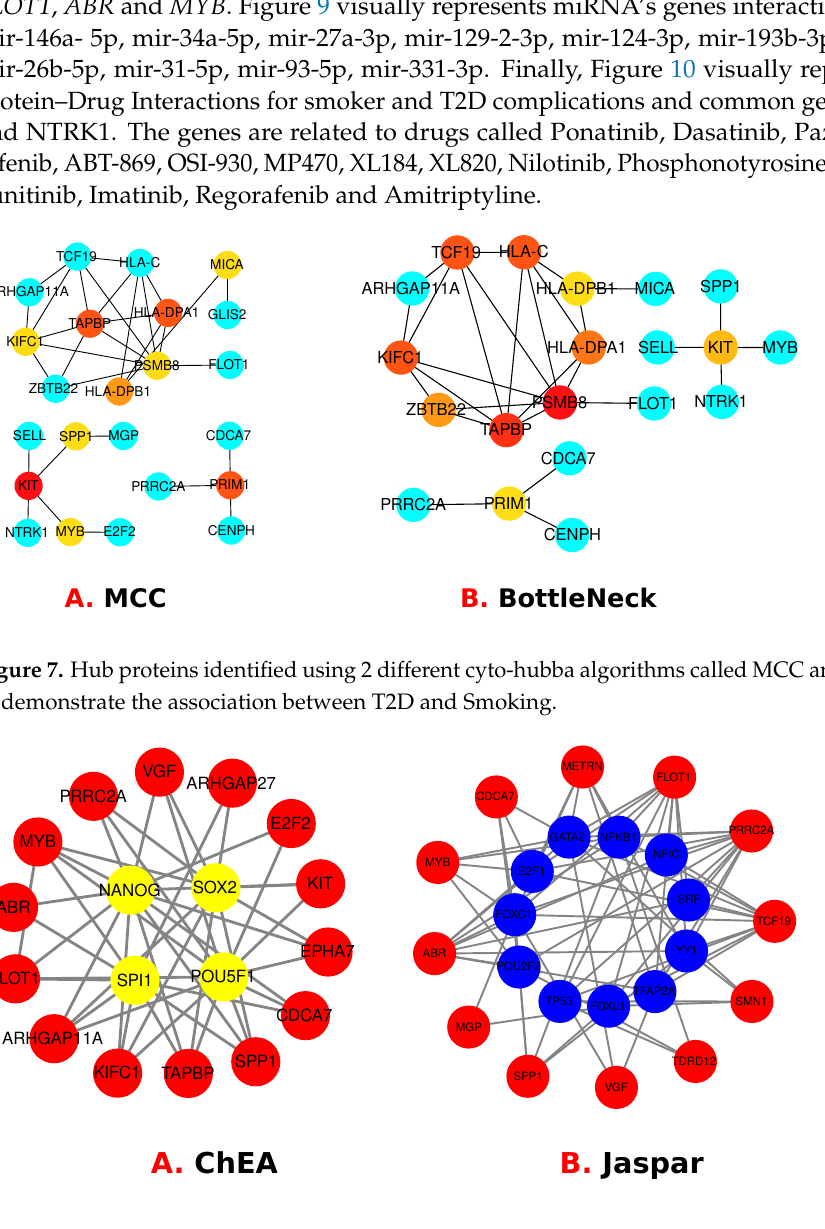
Figure 8. TF–Gene interactions showed using 2 different algorithms called ChEA and Jaspar to illustrate the linking between T2D and